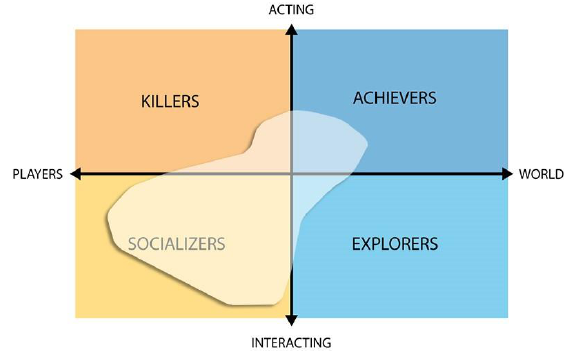
Figure 4. Required Behavior